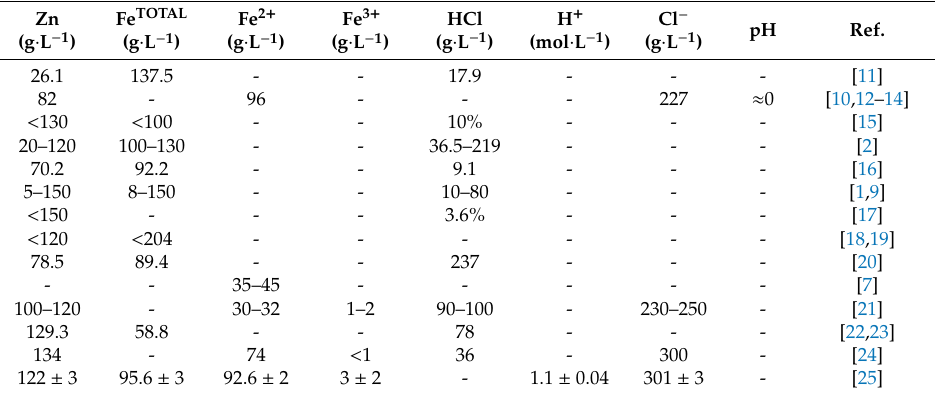
Table 1. Composition of real spent pickling acids based in